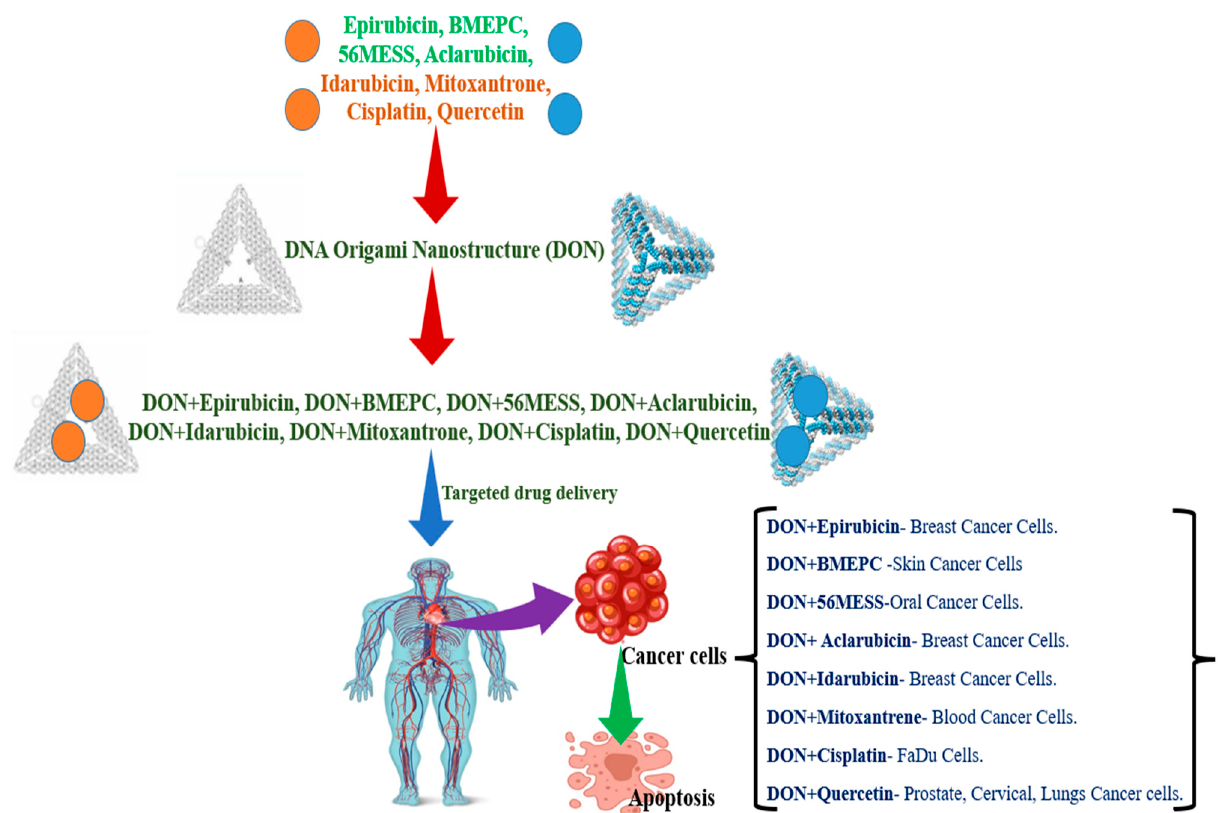
Figure 3. Schematic representation of DNA-origami-nanostructure-mediated targeted drug delivery for cancer therapy. [Epirubicin, BMEPC, 56MESS, Aclarubicin, Idarubicin, Mitoxantrone, Cisplatin, Quercetin are drugs; DON-DNA origami nanostructure].